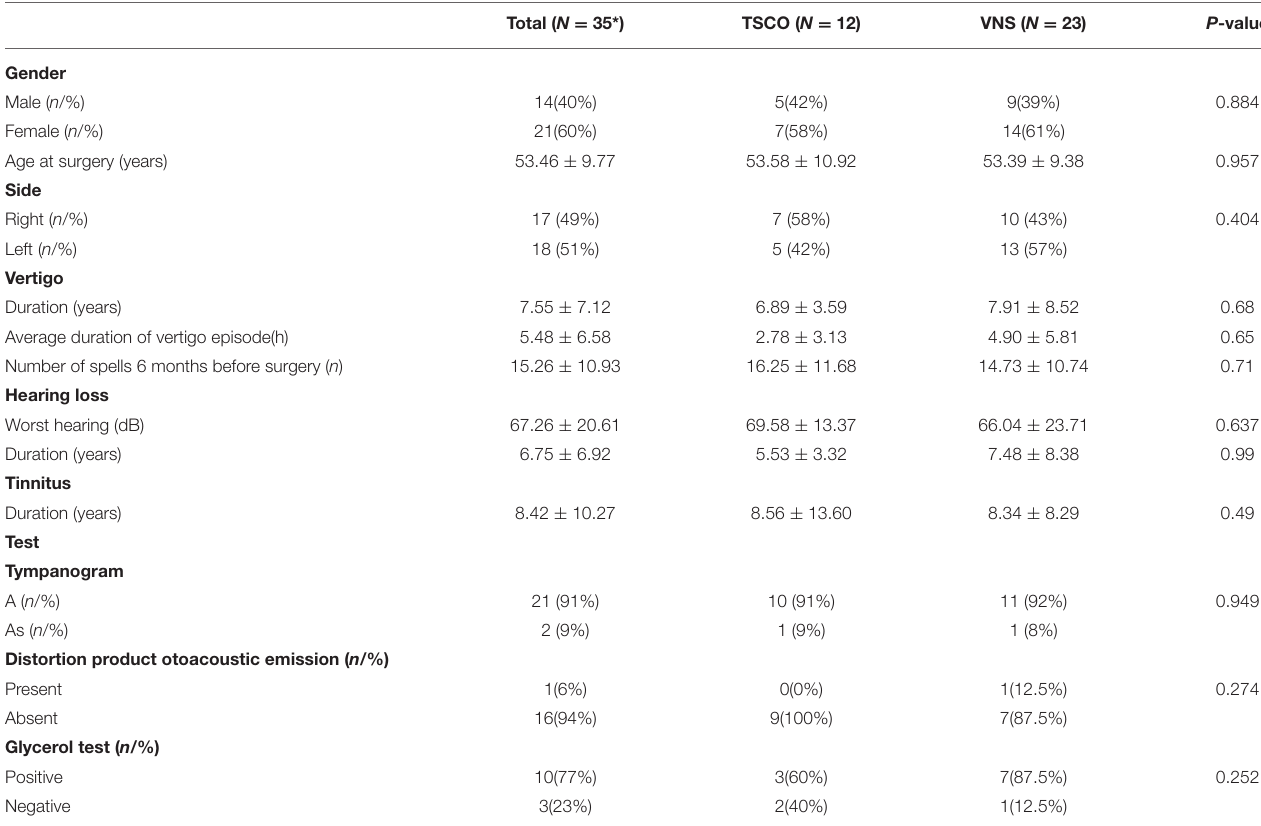
TABLE 1 | Patient demographics, symptoms, and results of tests before